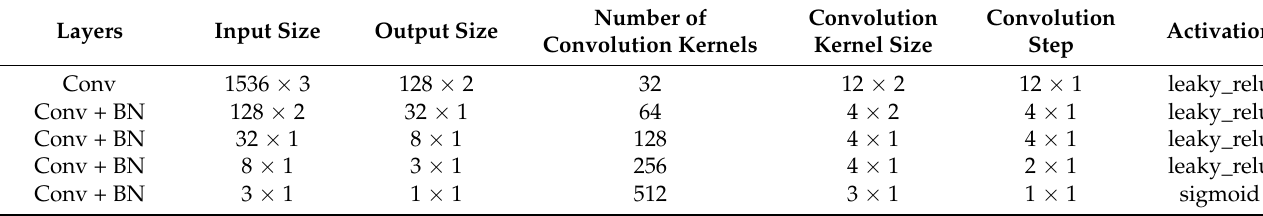
Table 2. The hidden layers of the